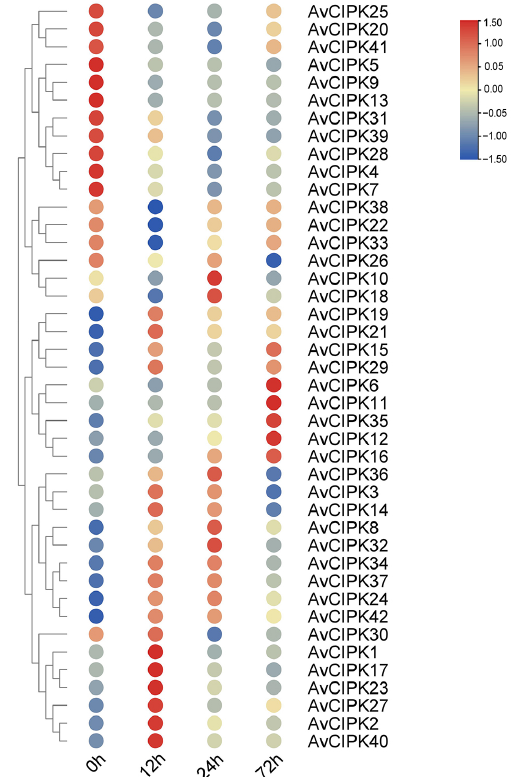
Figure 4. The heatmap for expression profile of kiwifruit CIPK family members under different time points of salt